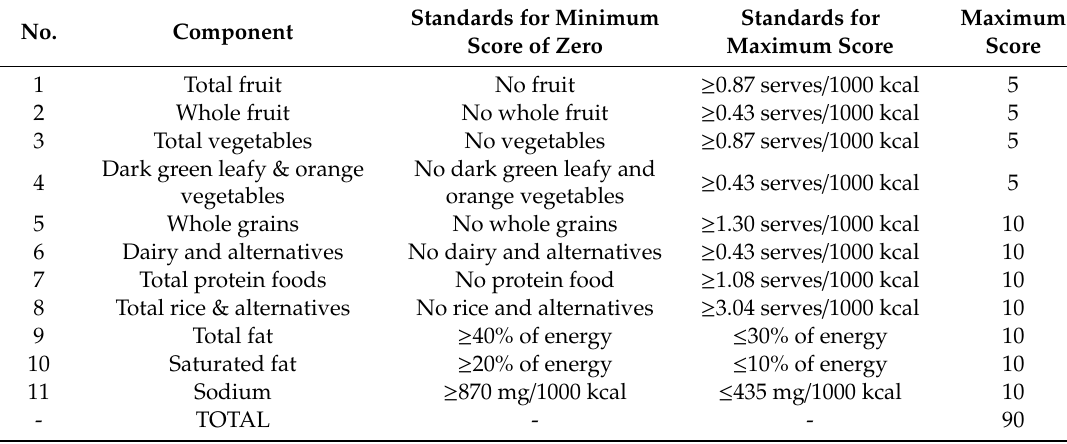
Table 1. Scoring elements used to calculate the Healthy Eating Index for Singaporean Adolescents